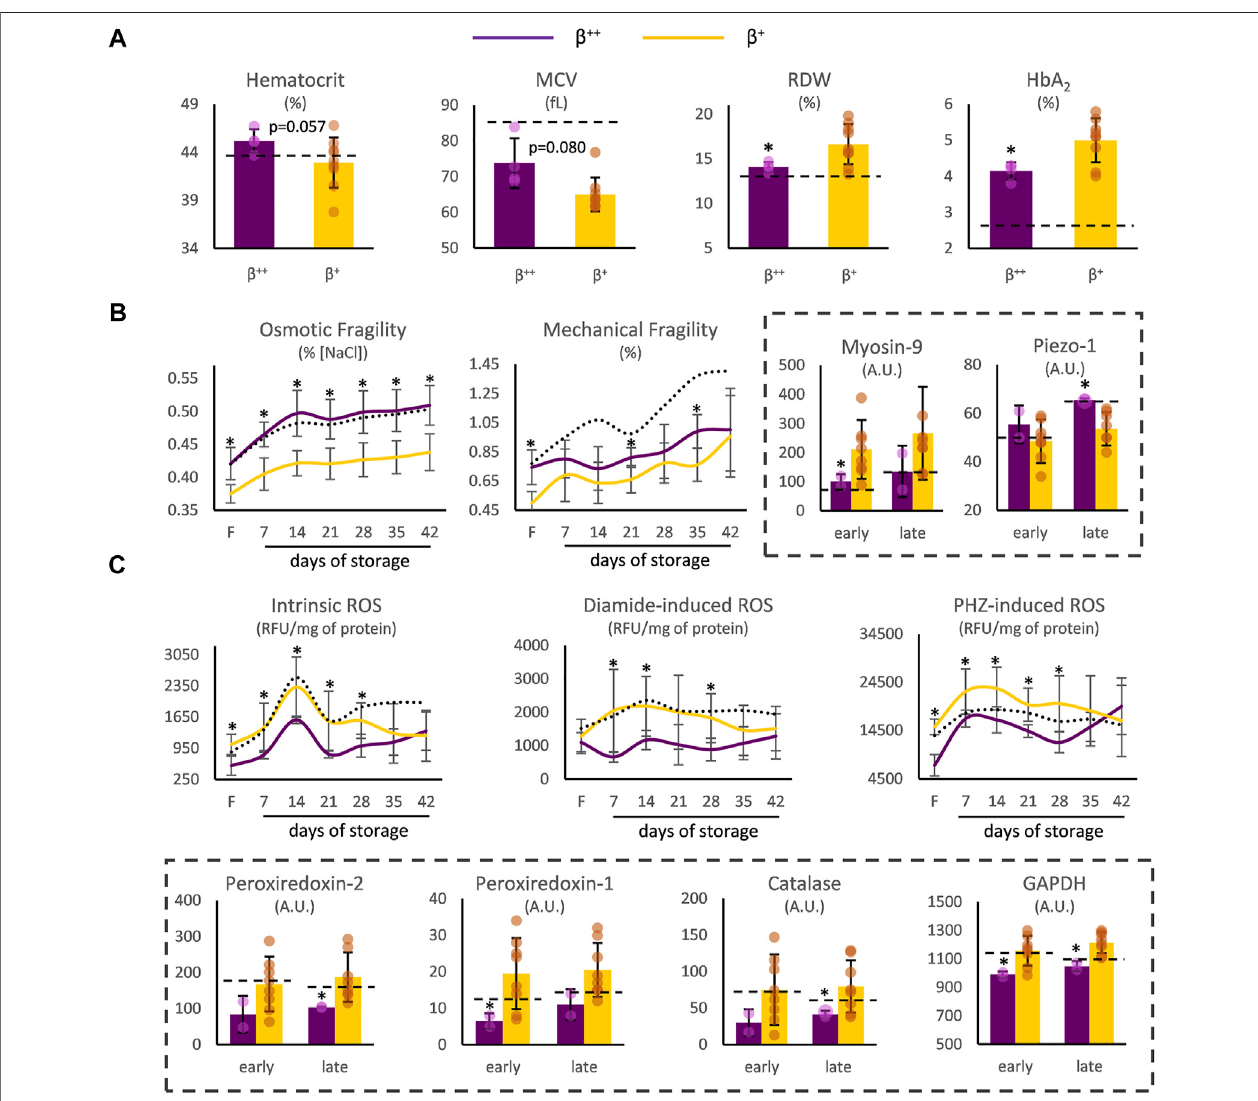
FIGURE 1 | RBC indices and physiology differences between β ++ and β + heterozygotes. (A) Hematological indices in freshly drawn blood. (B) Cellular fragility and (C) redox parameters beforeand during storage.Valuesforaveragecontrolsareshown bydashed lines.Proteomic parameters areshown indashed boxes( n =2vs. 8, β ++ vs. β + ). (*) p < 0.05. F: freshly drawn blood; A.U, arbitrary units; ROS: reactive oxygen species; RFU: relative fl uorescence units; PHZ: phenylhydrazine; GAPDH: glyceraldehyde-3-phosphate